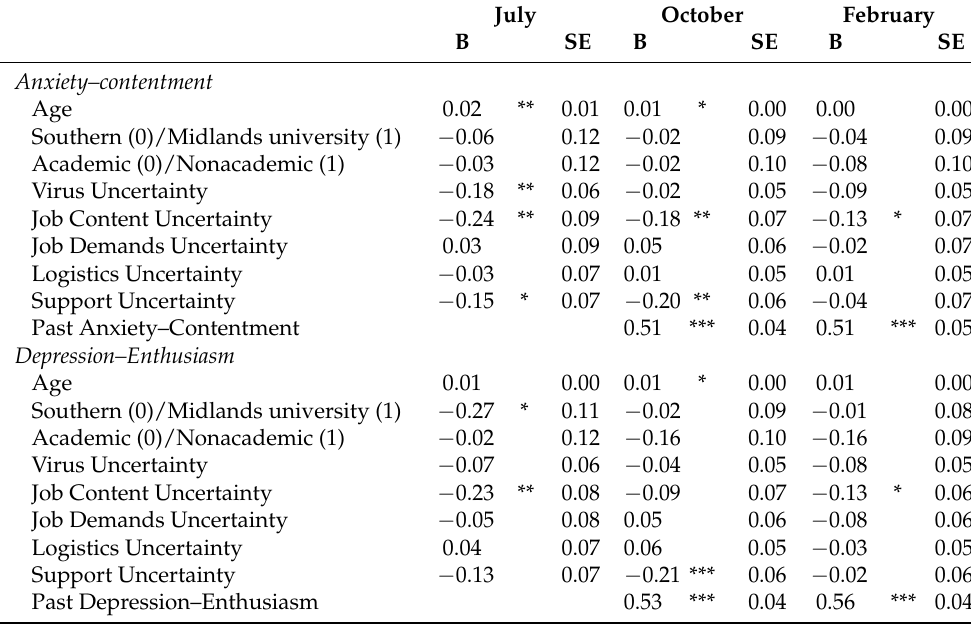
Table 5. Effects of uncertainty on changes in well-being in July, October, and February.